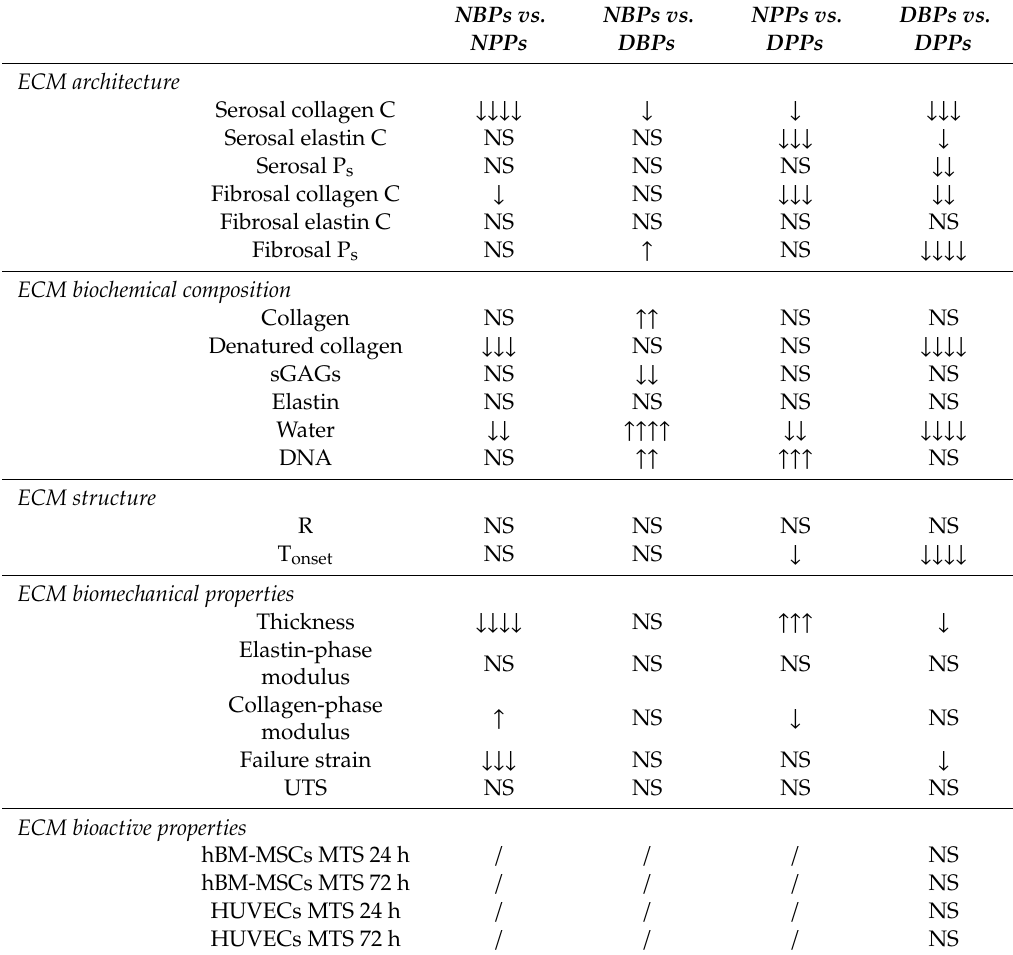
Table 1. Di ff erences Between Bovine and Porcine Pericardia Before and After TRICOL Decellularization. NBPs